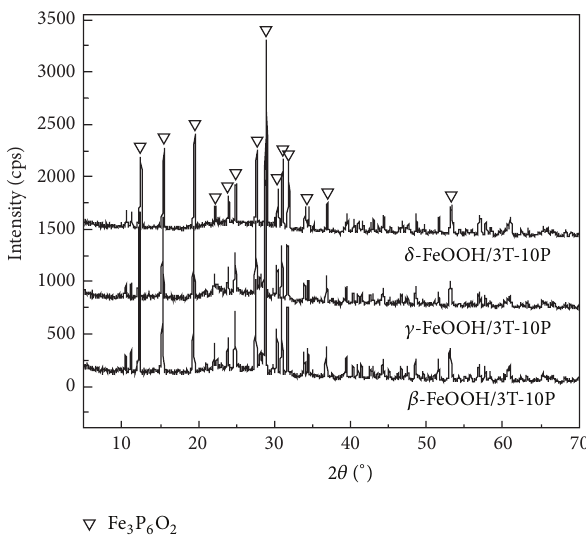
Figure 6: XRD patterns of the products formed from the reaction of FeOOH and 3T-10P.